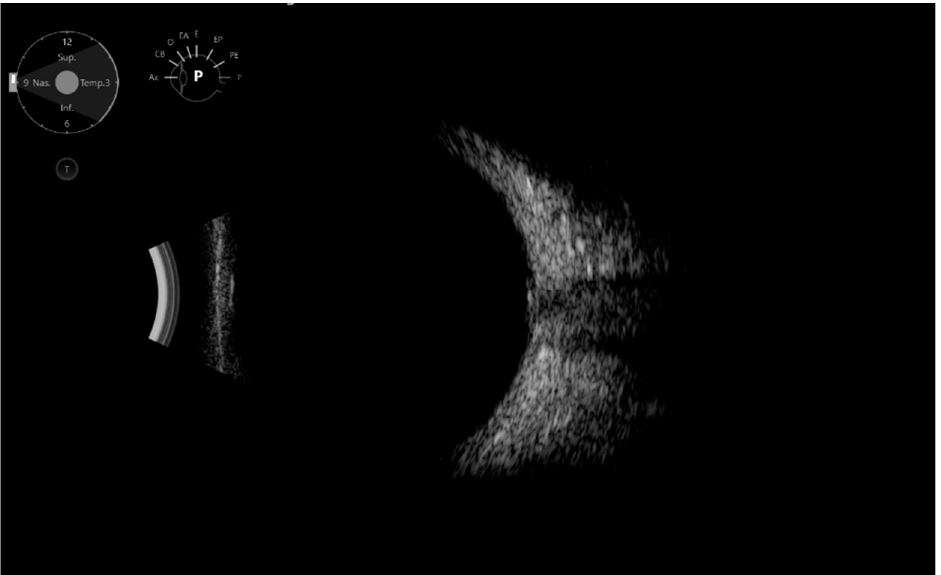
Figure 2. Ultrasound: Point-like optic disc drusen, visible as a highly reflective structure with a small posterior shadowing at the optic nerve level.